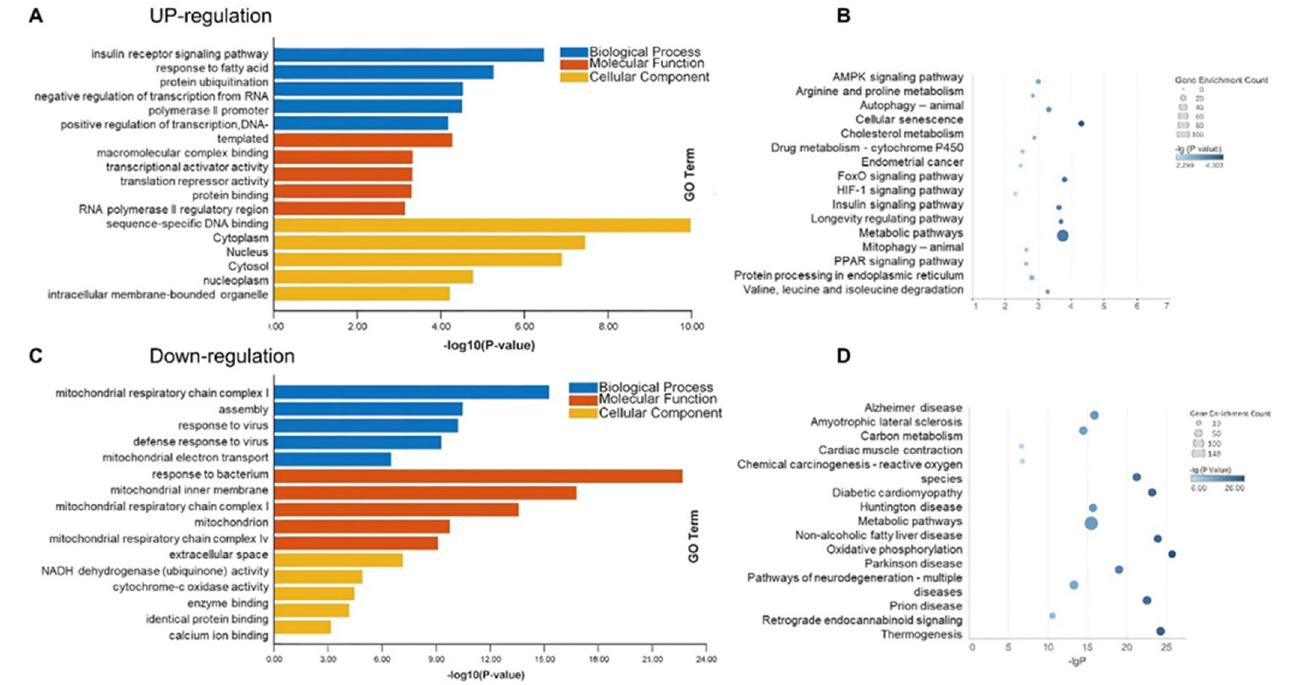
Figure 4. Enrichment of differential expression genes between sham group and MCAO group. ( A , B ) the up − regulation genes of GO and KEGG analysis. ( C , D ) the down − regulation genes of GO and KEGG analysis.